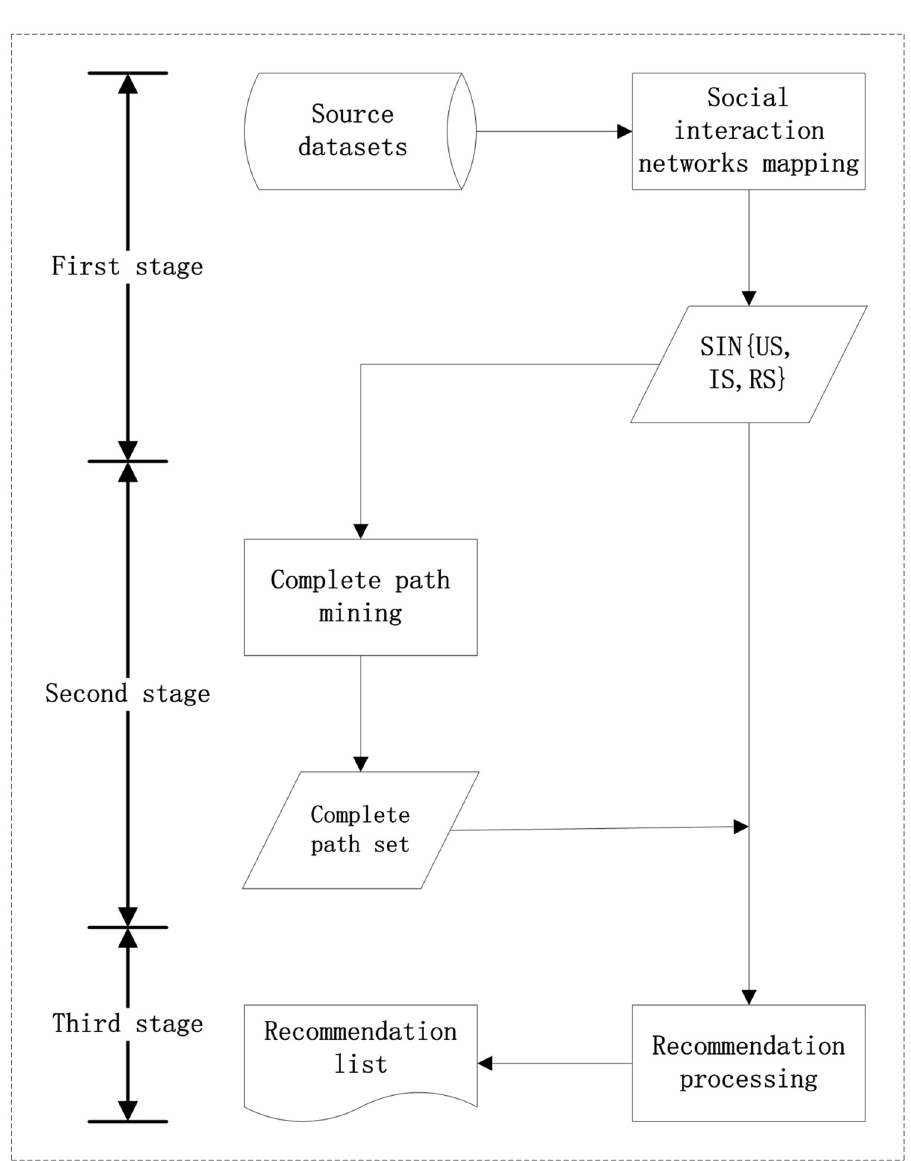
Fig 2. Framework of SRUI